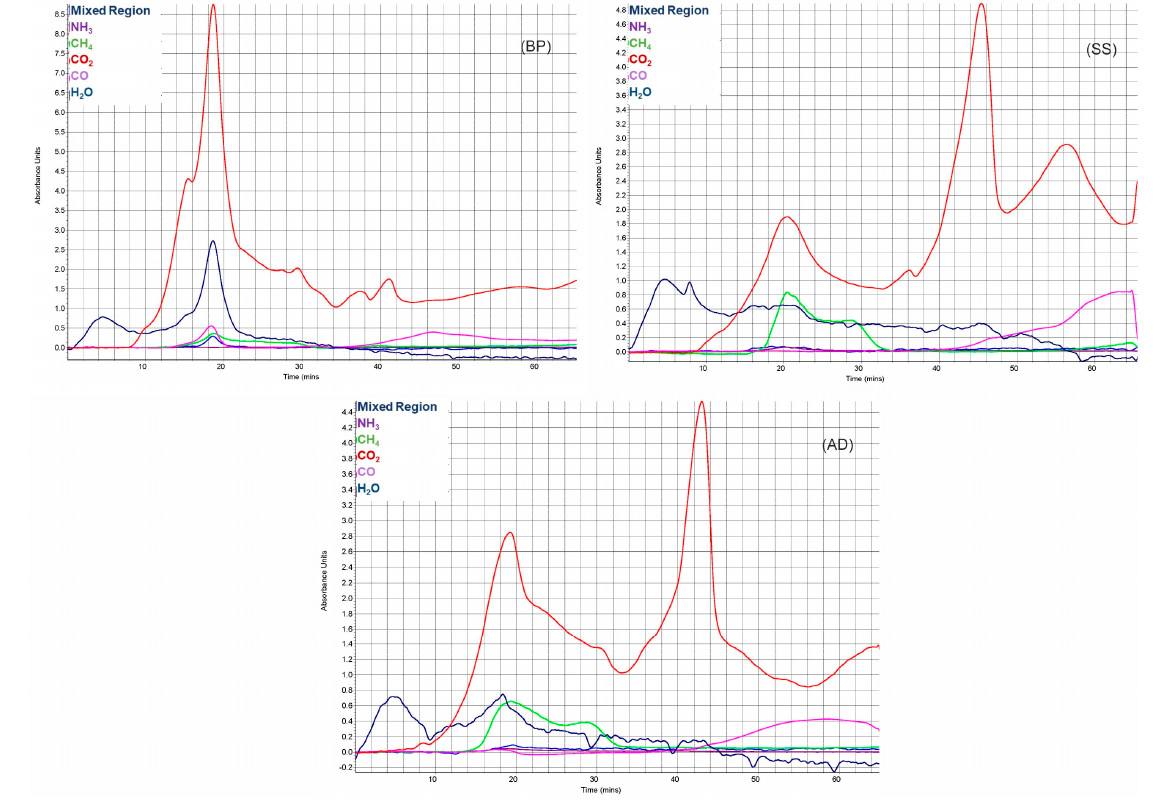
Figure 3. Emission profile of CO 2 , CO, CH 4 , H 2 O, NH 3 during pyrolysis (at 15 °C/min) of BP, SS, and AD plotted against pyrolysis time.